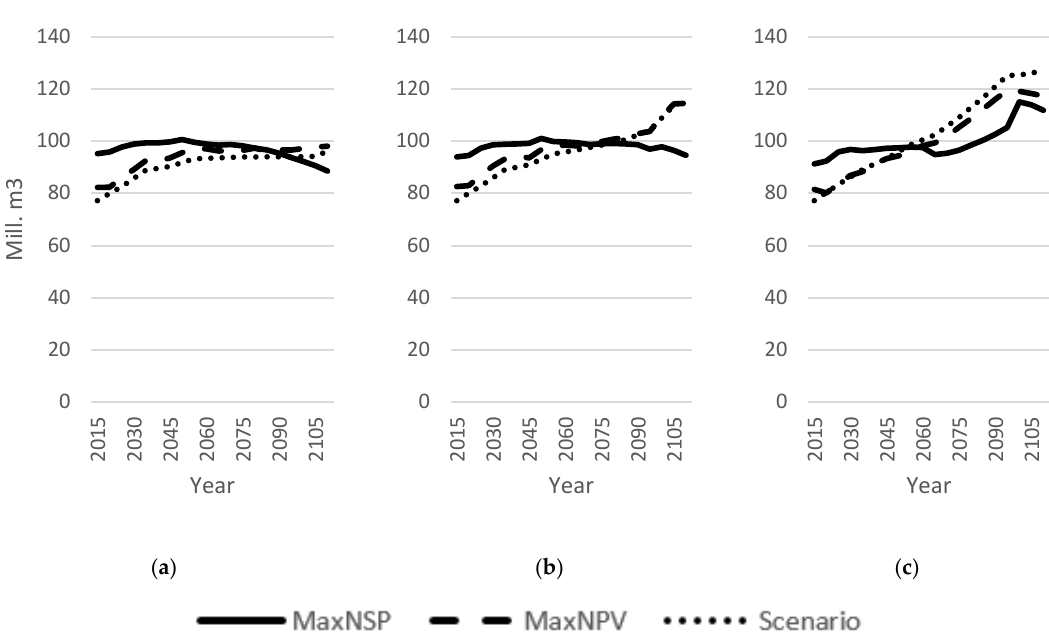
Figure 3. Total national harvest volume entering sawmills, pulp mills and heating plants for three scenarios computed with SweFor for demand specifications MaxNSP and MaxNPV (m 3 o.b. including treetops) and the harvest volume specified in the GLOBIOM national scenario destined for sawmills and pulp mills. ( a ) Scenario RCP4p5.SSP3; ( b ) scenario RCP2p6.SSP4; ( c ) scenario RCP2p6.SSP5.